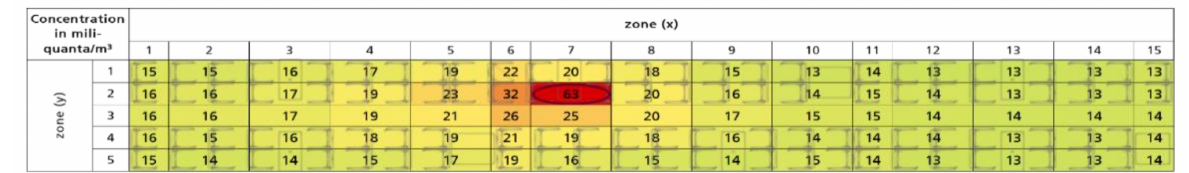
Figure 8. Example of concentration distribution in mili-quanta per m 3 for the case “HVAC heating, 50% occupancy, talking, without mask” in ICE.